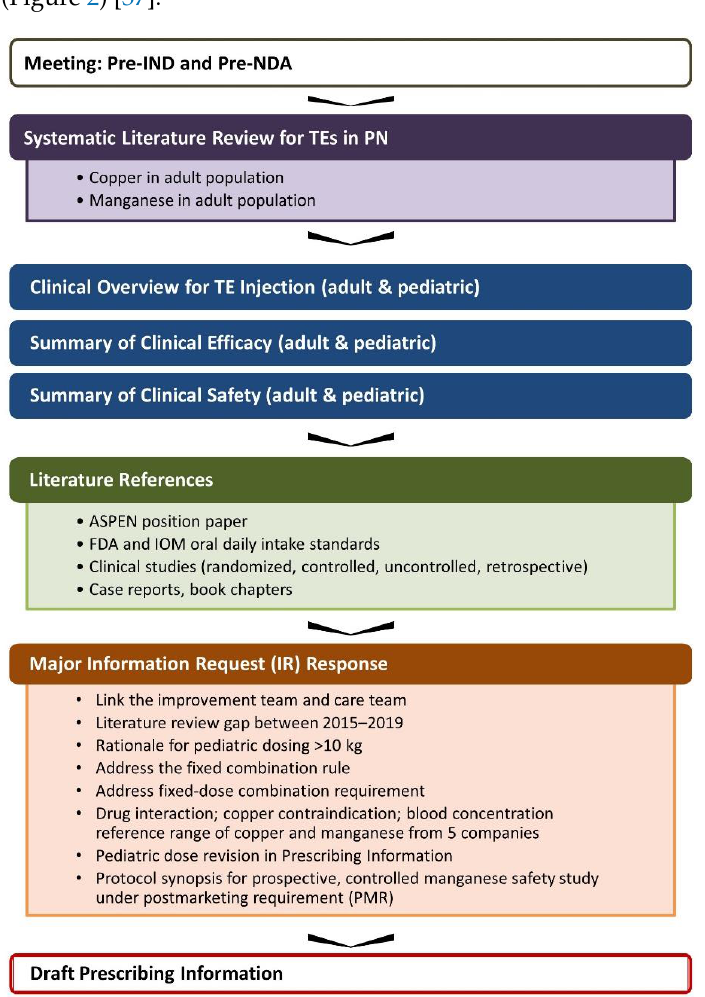
Figure 2. Summary of review materials and analysis included in literature assessments for 505(b)(2) NDA 209376 submission. ASPEN, American Society for Parenteral and Enteral Nutrition; FDA, United States Food and Drug Administration; IND, investigational new drug application; IR, infor- mation request; IOM, Institute of Medicine; NDA, new drug application; PMR, postmarketing re- quirement; PN, parenteral nutrition; TE, trace